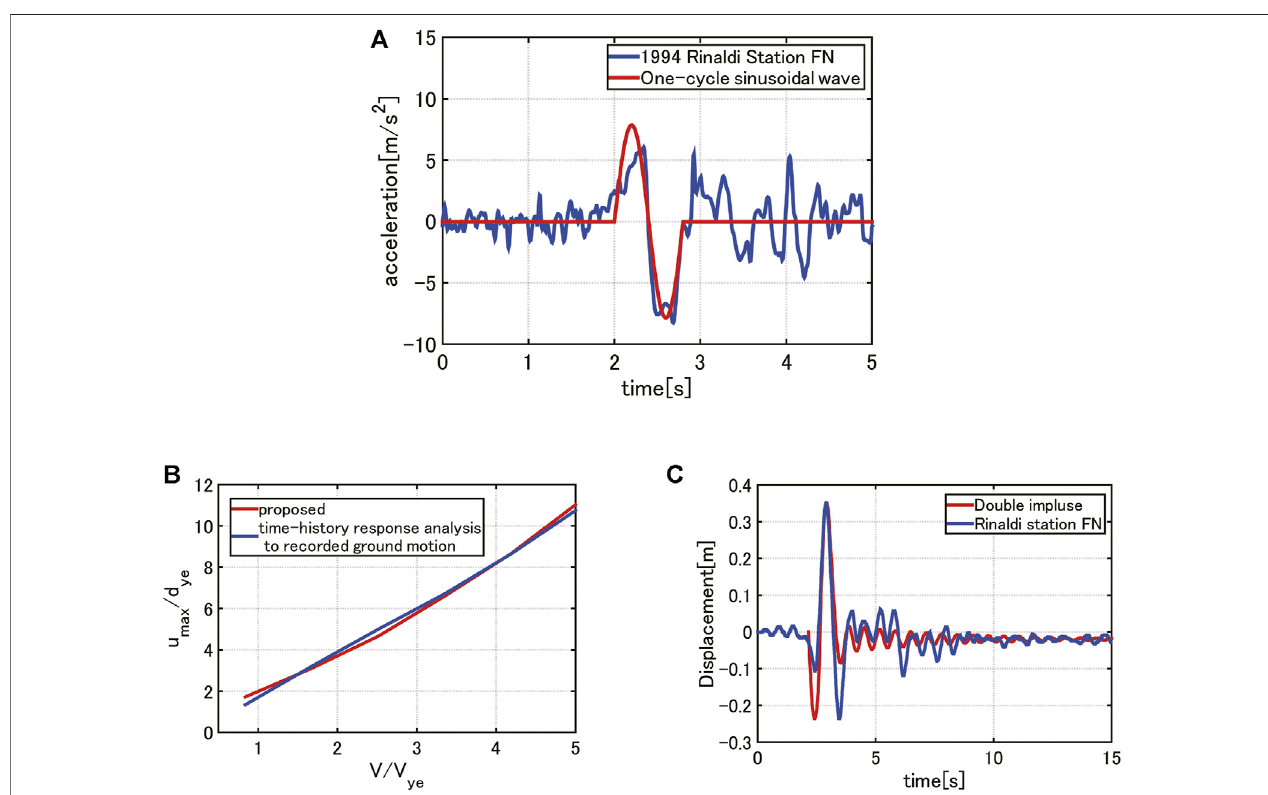
FIGURE 13 | Comparison of proposed evaluation method with time-history response analysis for recorded ground motion, (A) Rinaldi Station FN comp. (1994 Northridge) and one-cycle sinusoidal wave, (B) Maximum displacement of SDOF model by the proposed method under critical double impulse and by time-history response analysis under recorded ground motion, (C) Time-history response analysis for SDOF model under critical double impulse and recorded ground motion for V / V ye (cid:2) 4 . 19.